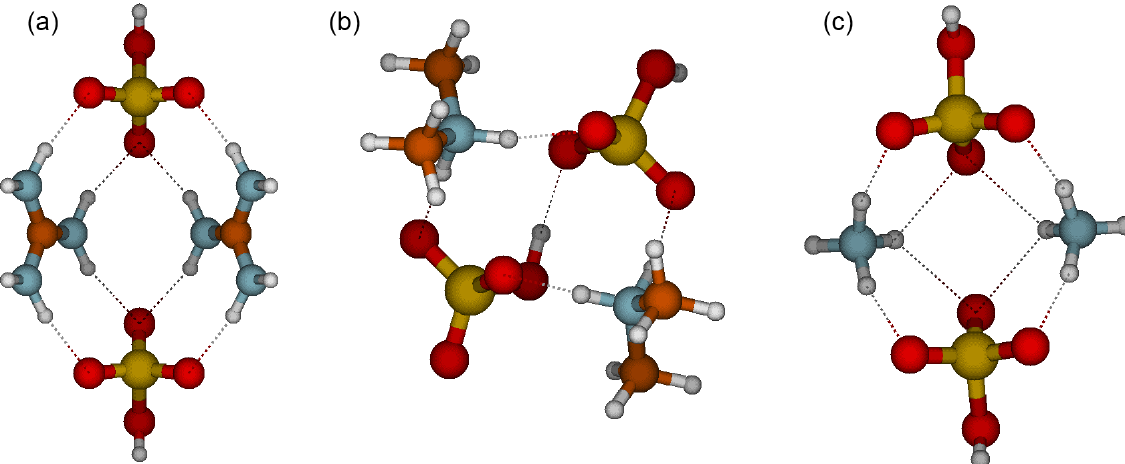
Figure 3. Molecular structures of clusters containing two sulfuric acid and two base molecules for guanidine (a) , dimethylamine (b) and ammonia (c) . Color coding: brown is carbon, blue is nitrogen, red is oxygen, yellow is sulfur and white is hydrogen.